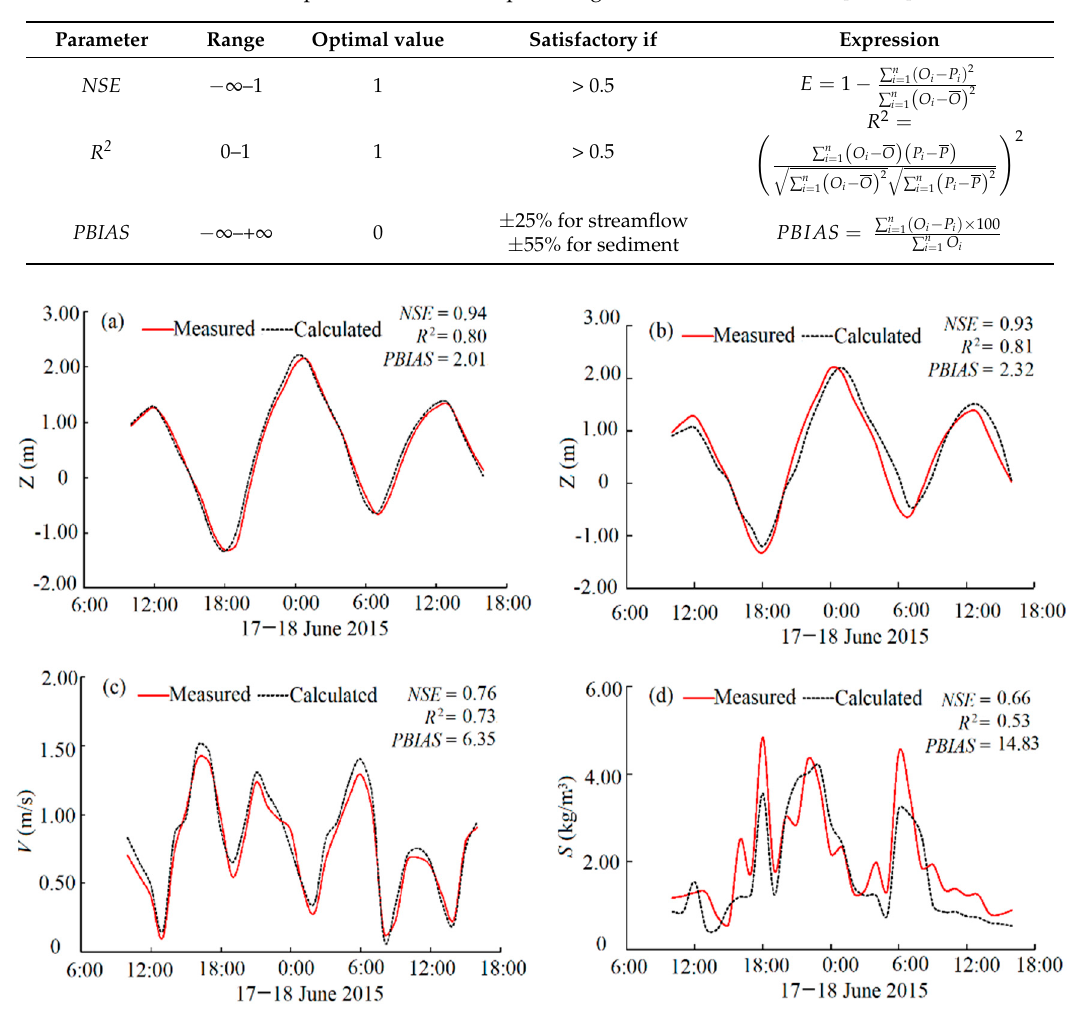
Table 5. Error parameters and accepted ranges for model evaluation [25–27].